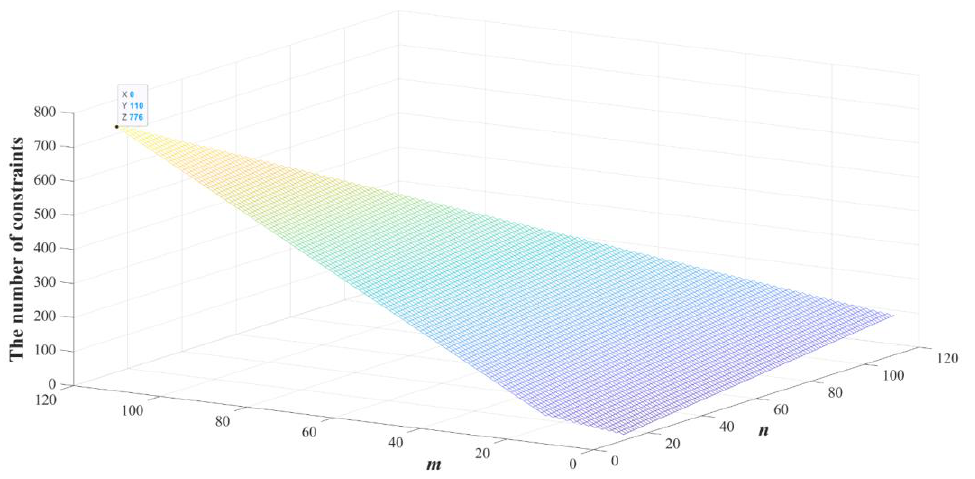
Figure 7. The number of constraints of the developed ILP for different cases.